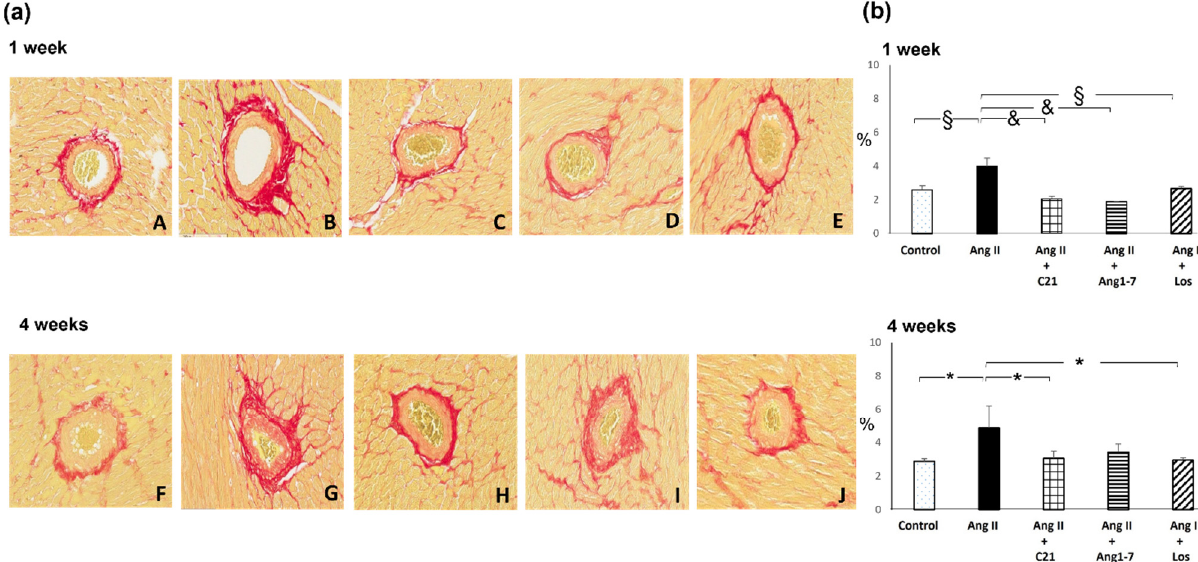
Figure 2. Myocardial perivascular fibrosis. Effects of C21 and Ang 1-7 administration on myocardial perivascular fibrosis in Ang II treated rats for 1 and 4 weeks. ( a ). Representative photomicrographs of perivascular fibrosis in control (A,F), Ang II (B,G), Ang II + C21 (C,H), Ang II + Ang 1-7 (D,I) and Ang II + Los (E,J) treated rats ( × 20 magnification), after 1 and 4 weeks of treatment. ( b ). Quantification of perivascular fibrosis in the different groups of rats. Data are means ± SEM. *: p < 0.05. §: p < 0.01. &: p < 0.0001.